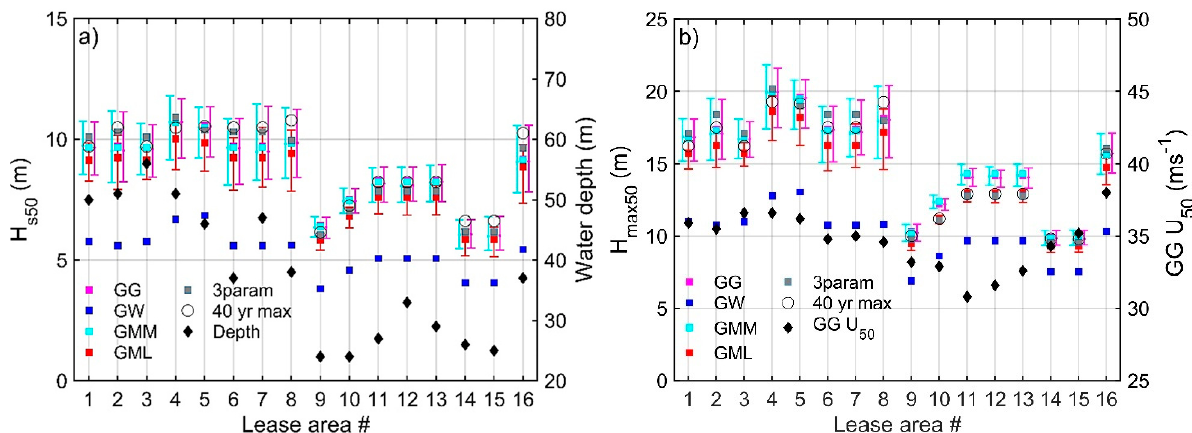
Figure 10. The 50-year return period estimates of ( a ) H s and ( b ) H max over the 16 LA from the different distribution fitting approaches. Figure ( a ) also shows water depth at the central location of each LA and Figure ( b ) shows the GG U 50 wind speed for each LA.